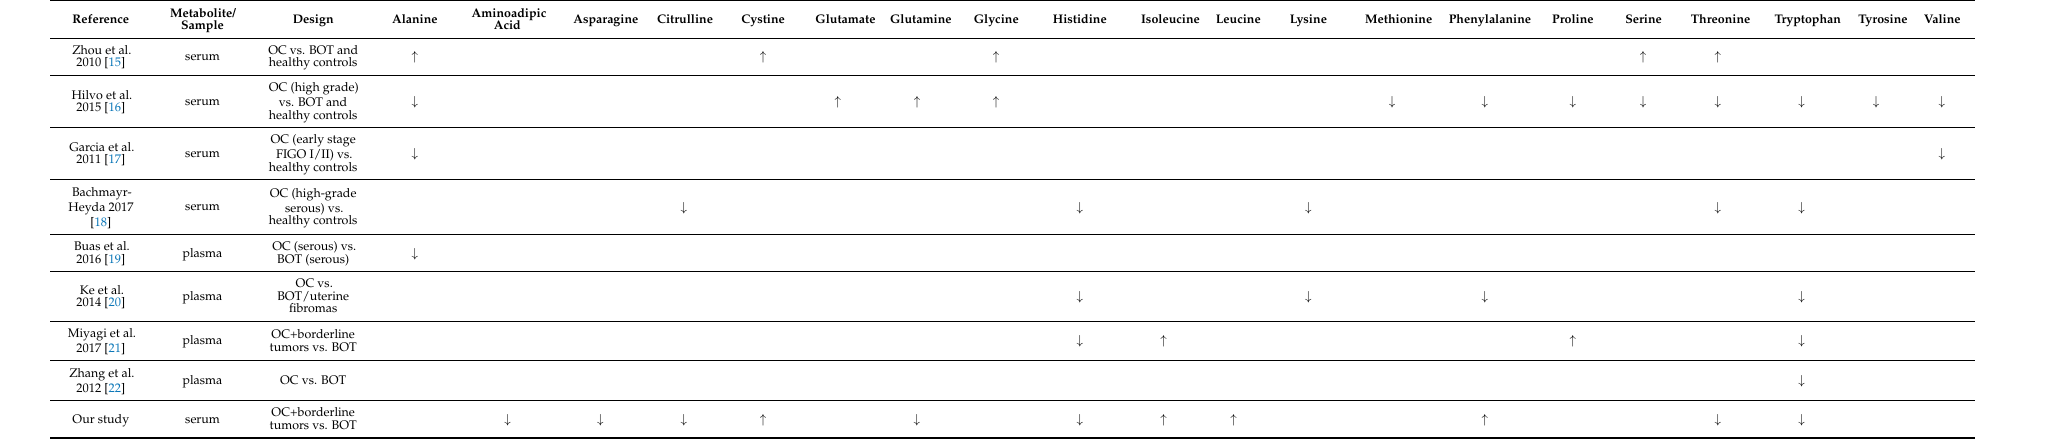
Table 5. Overview of metabolomic studies on ovarian cancer (OC) and their results: concentrations of several amino acids were significantly different in OC compared to benign ovarian tumors (BOTs) and/or healthy